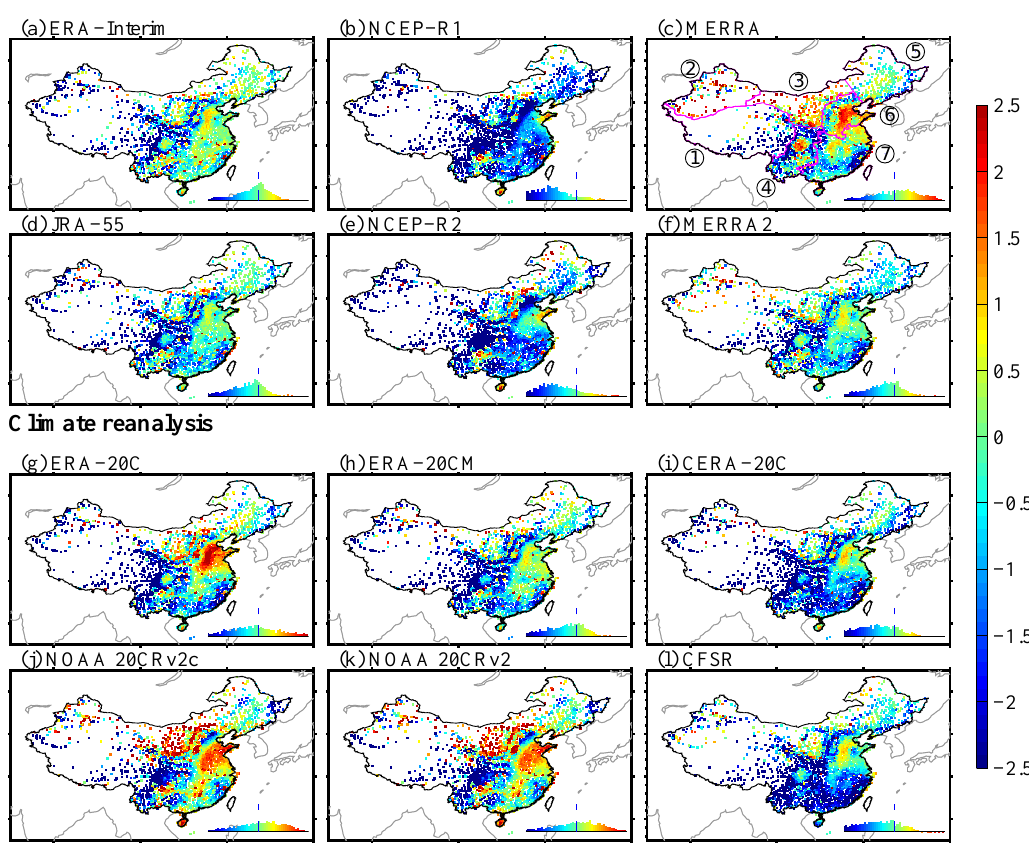
Figure 1. The multiyear-averaged differences in surface air temperatures ( T a , unit: ◦ C) during the period of 1979–2010 from the 12 reanalysis products relative to the homogenized observations over China. The reanalysis products are (a) ERA-Interim, (b) NCEP-R1, (c) MERRA, (d) JRA-55, (e) NCEP-R2, (f) MERRA2, (g) ERA-20C, (h) ERA-20CM, (i) CERA-20C, (j) NOAA 20CRv2c, (k) NOAA 20CRv2 and (l) CFSR. The mainland of China is divided into seven regions (shown in c ), specifically (1) the Tibetan Plateau, (2) northwestern China, (3) the Loess Plateau, (4) middle China, (5) northeastern China, (6) the North China Plain and (7) southern China. Table 2. Differences (unit: ◦ C) relative to the homogenized observations and trends (unit: ◦ Cdecade − 1 ) in surface air temperatures ( T a ) from 1979 to 2010 over China and its seven subregions. The bold font indicates results that are significant according to two-tailed Student’s t tests with a significance level of 0.05.